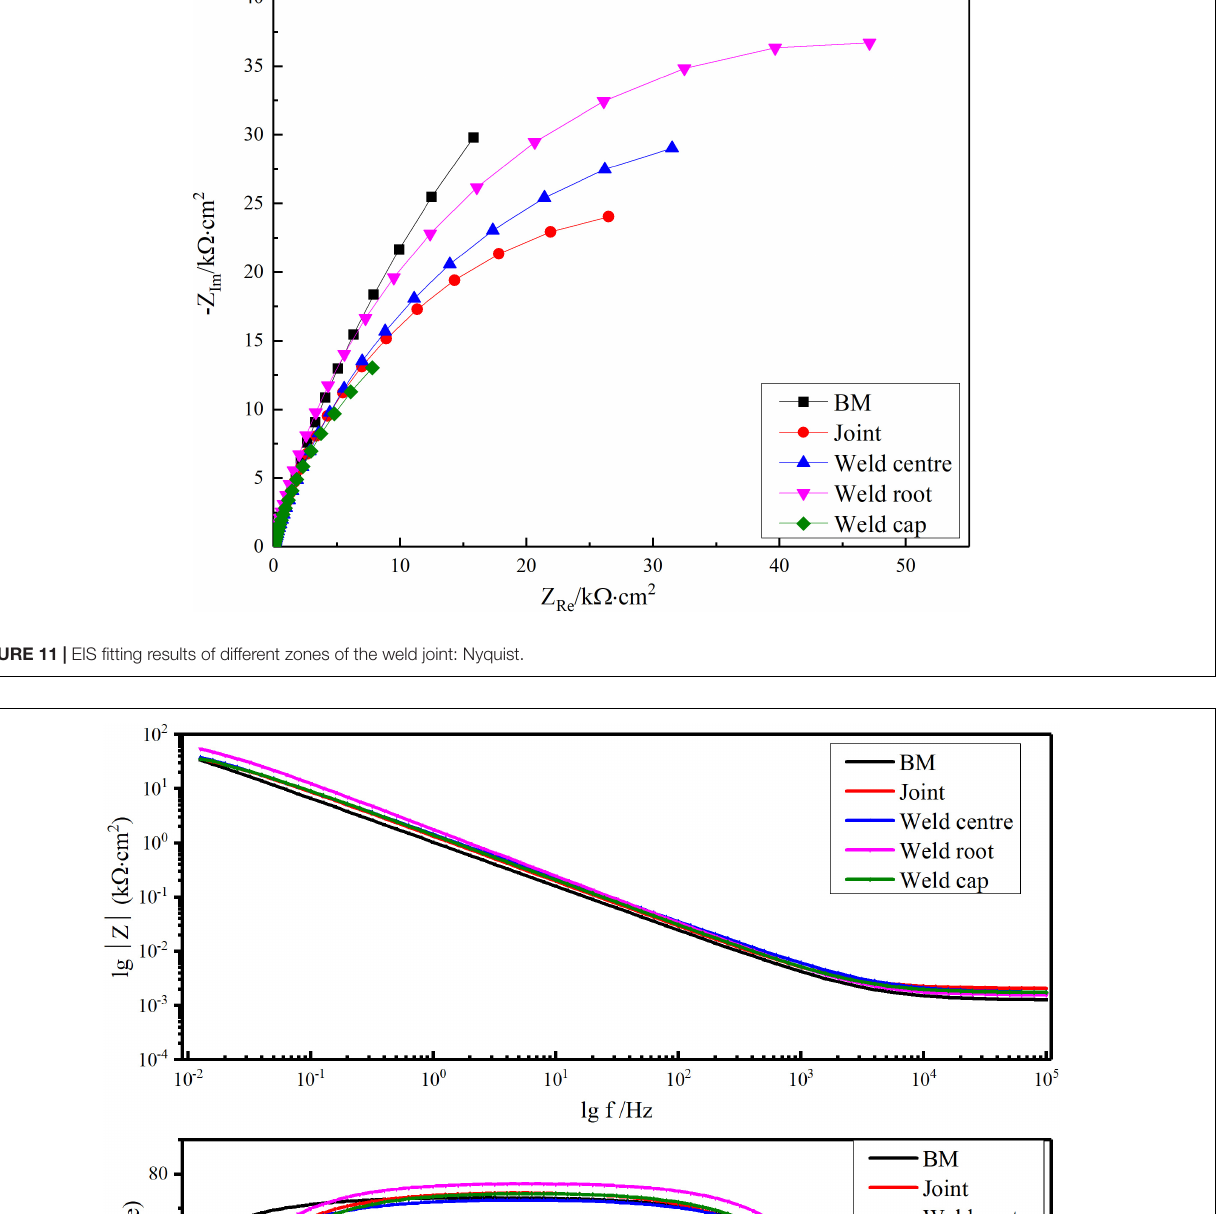
Frontiers in Materials |